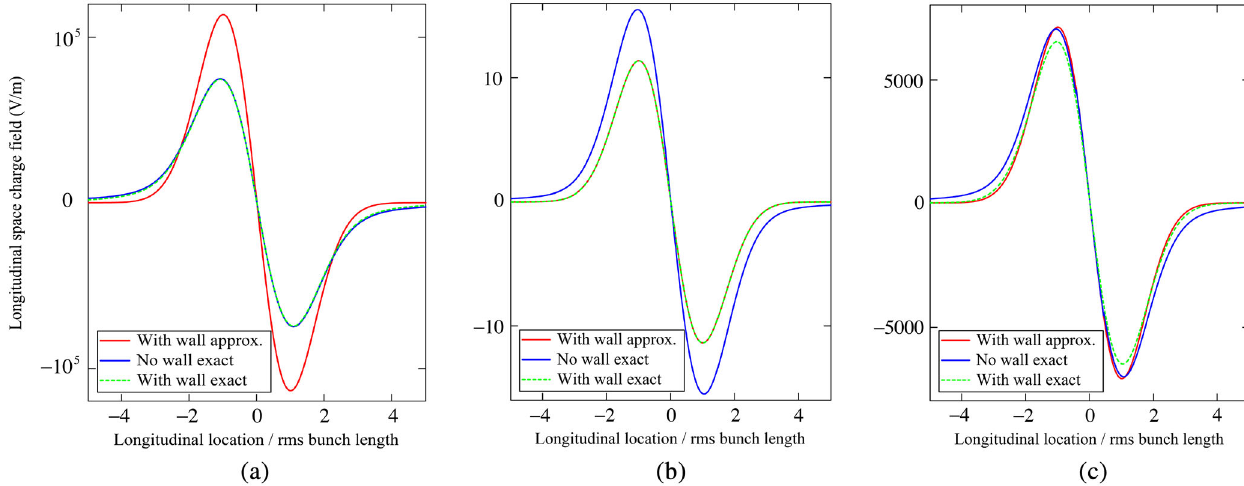
14. The exact longitudinal space charge field in the presence of the 5 cm radius beam pipe. The abscissas are the longitudinal locations in units of the rms bunch length and the ordinates are the longitudinal space charge field in units of V/m. The green dashed curve shows the field calculated from the exact solution, i.e., Eq. (B44), the blue solid curve shows the field from the electron bunch, without considering the beam pipe, and the red solid curve shows the field calculated from an approximate formula where shielding from the beam pipe is considered but the electron bunch is assumed to be much longer than the beam pipe ’ s radius. (a) Calculated for PoP parameters but with 1.26 cm beam frame rms bunch length; (b) calculated with 1.26 m beam framerms bunch length;(c) calculated with 5 cm beam frame rms bunch